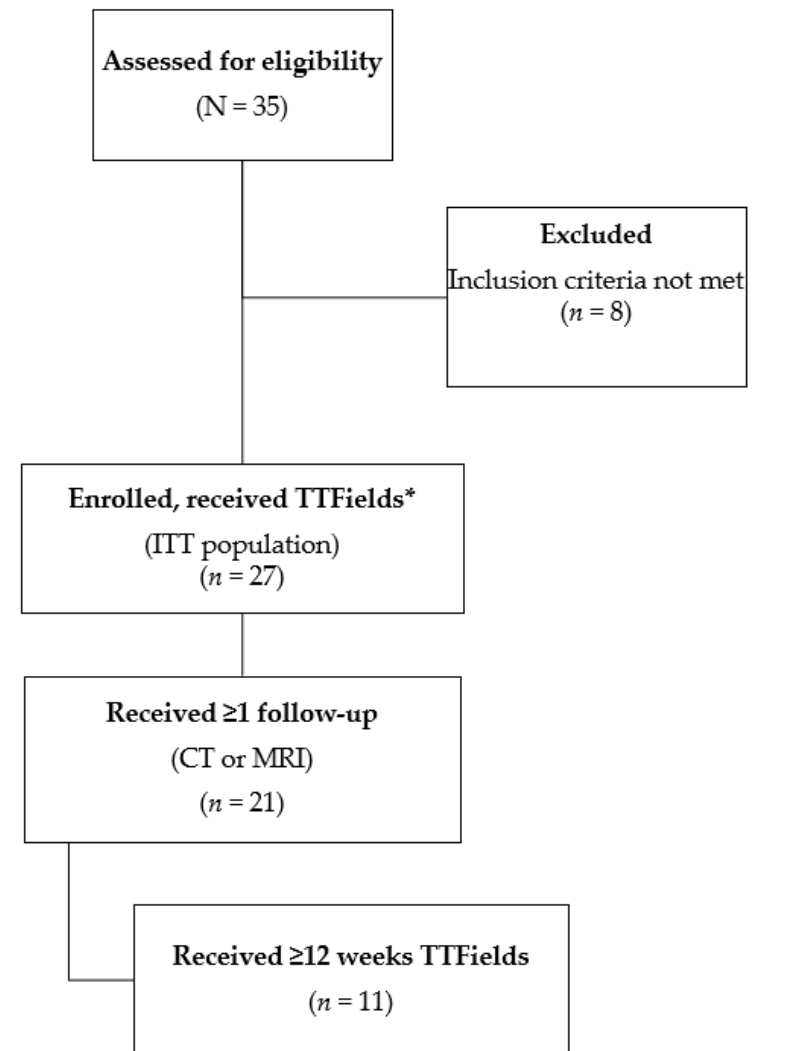
Figure 3. Patient flow diagram. *One patient did not receive concomitant sorafenib treatment.